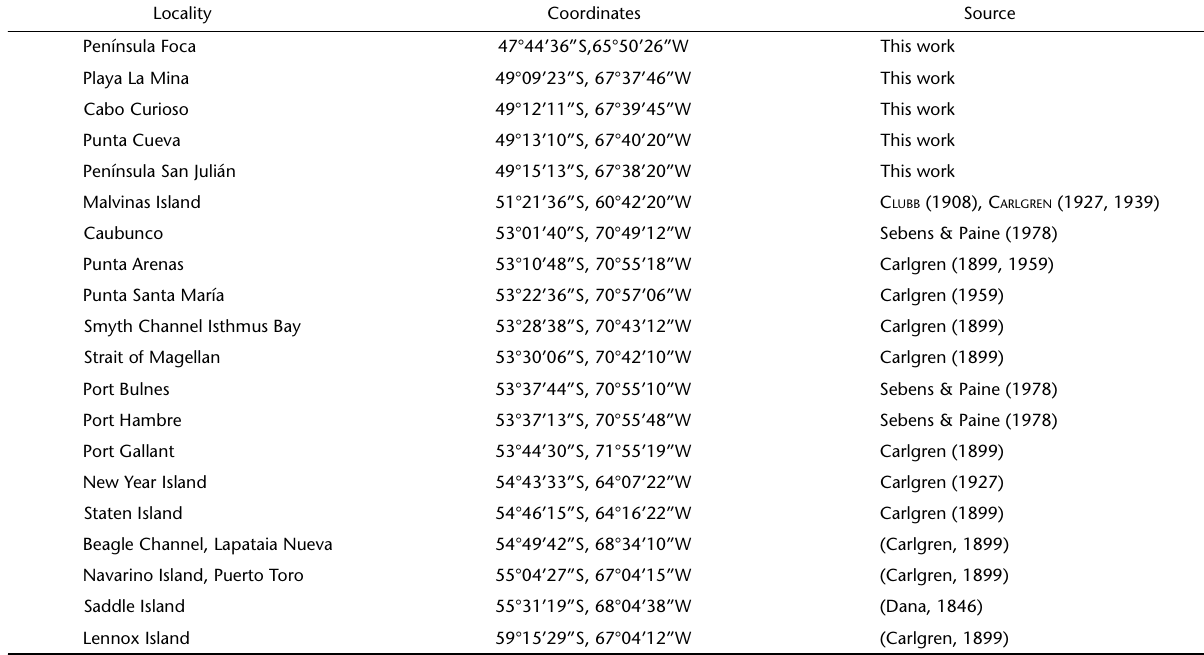
Table II. Distribution of Bunodactis